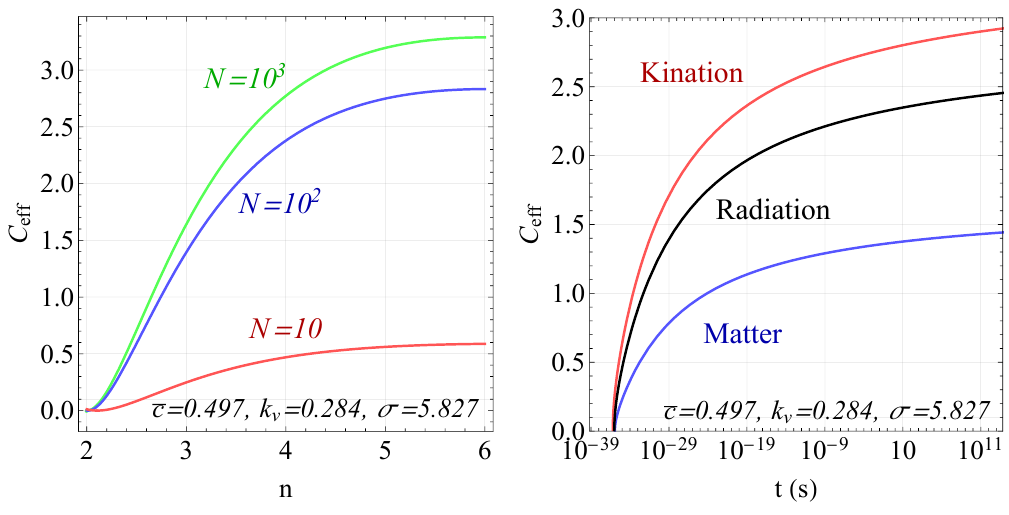
Figure 2 . The dependence of loop emission factor C eff on the background cosmology as derived from the VOS model, as well as its evolution in time (characterized by N ≡ ln L ( t ) example shown, the symmetry breaking scale is taken as η = 10 15